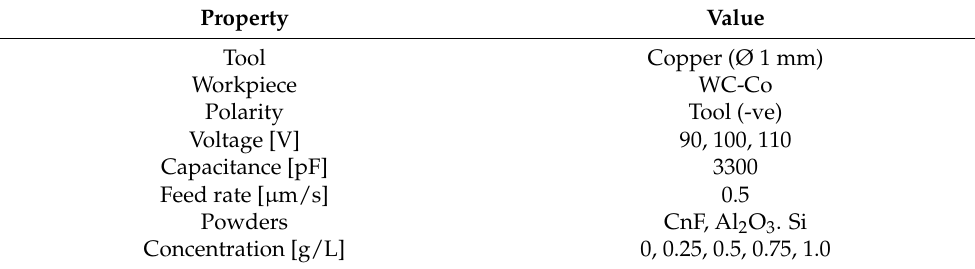
Table 3. Machining